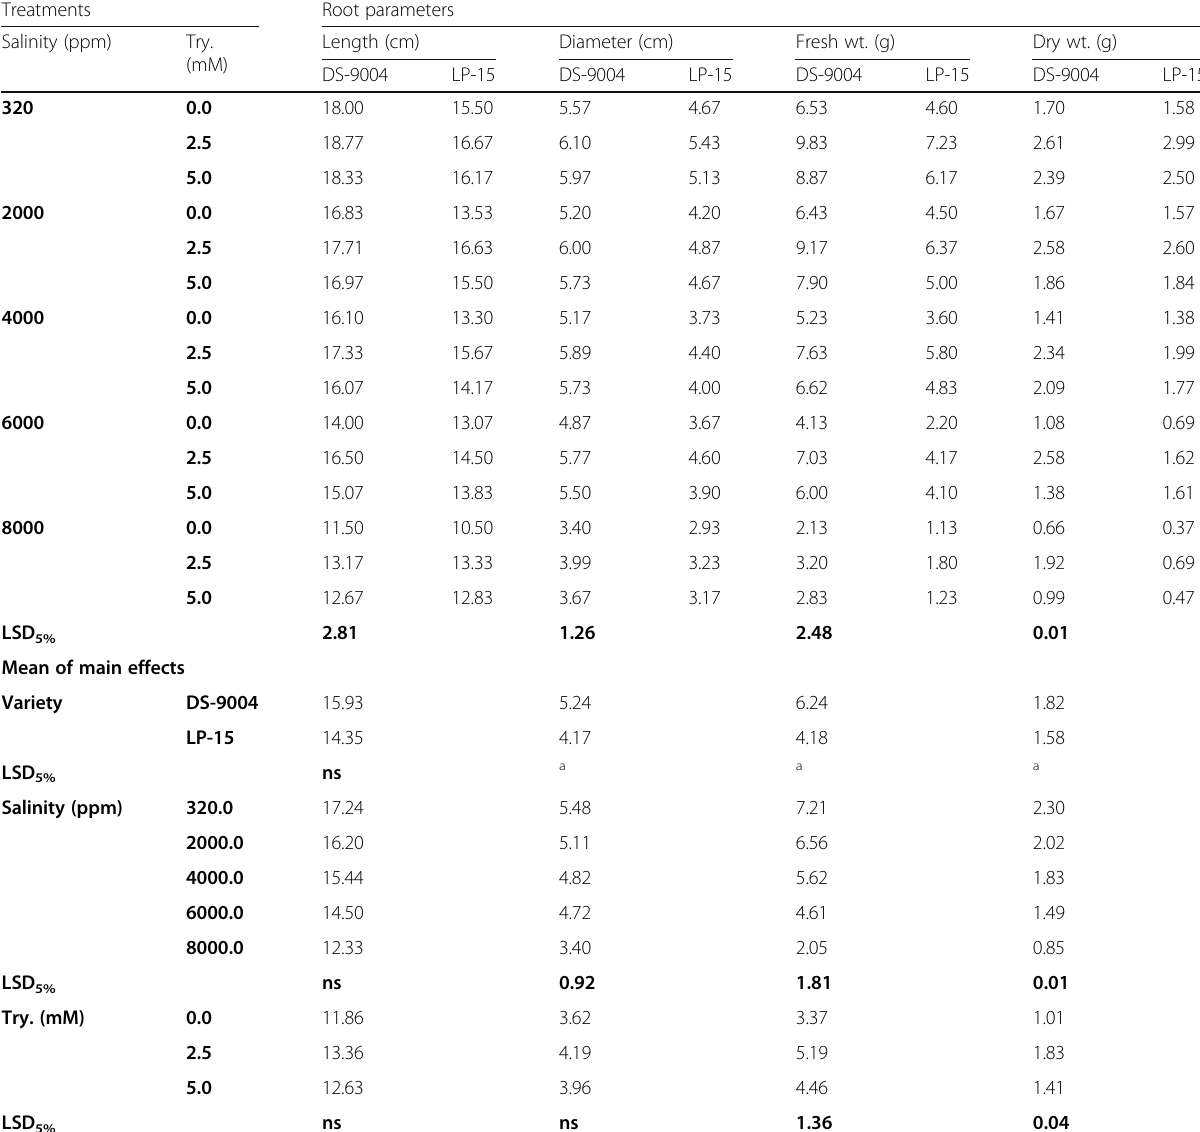
Table 2 Effect of pre-soaking two sugar beet seed cultivars with tryptophan and irrigated with different levels of salinity on root parameters at 75 days after sowing Treatments Root parameters Salinity